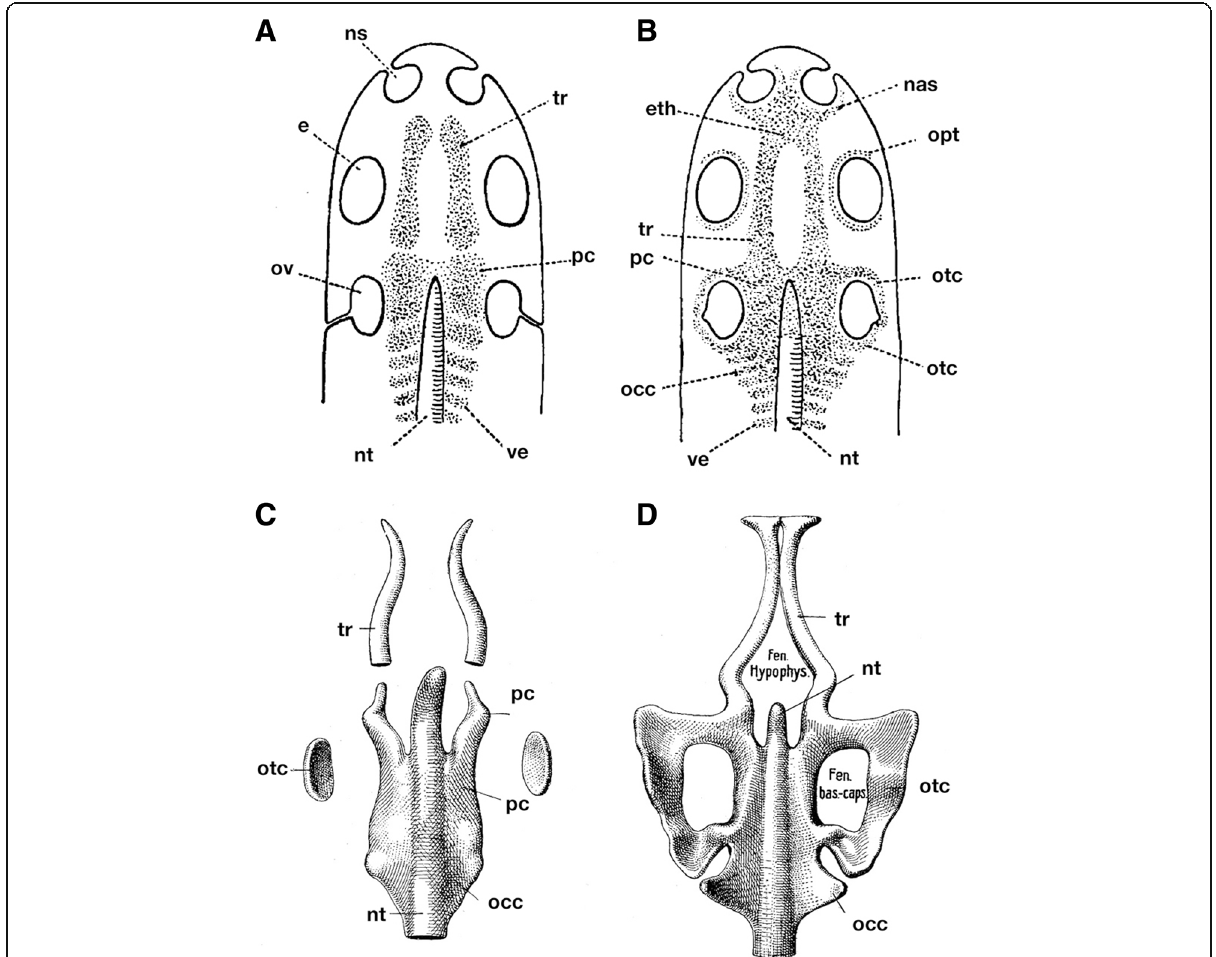
Fig. 1 a and b Schematized composition of crown gnathostome cranium. Early ( a ) and late ( b ) stages of development. Precartilaginous condensation and cartilages are shown in dots. Based on reference [8]. c and d . Early ( c ) and late ( b ) stages of chondrocranium in Salmo . Based on reference [42]. e, eye; eth, ethmoidal plate; Fen. bas.-caps., basicapsular fenestra; Fe, hypophys., hypophyseal fenestra; nas, nasal capsule; ns, nasal sac; nt, notochord; occ, occipital cartilage; opt, optic capsule; otc, otic capsule; ov, otic vesicle; pc, parachordals; tr, trabecula; ve,